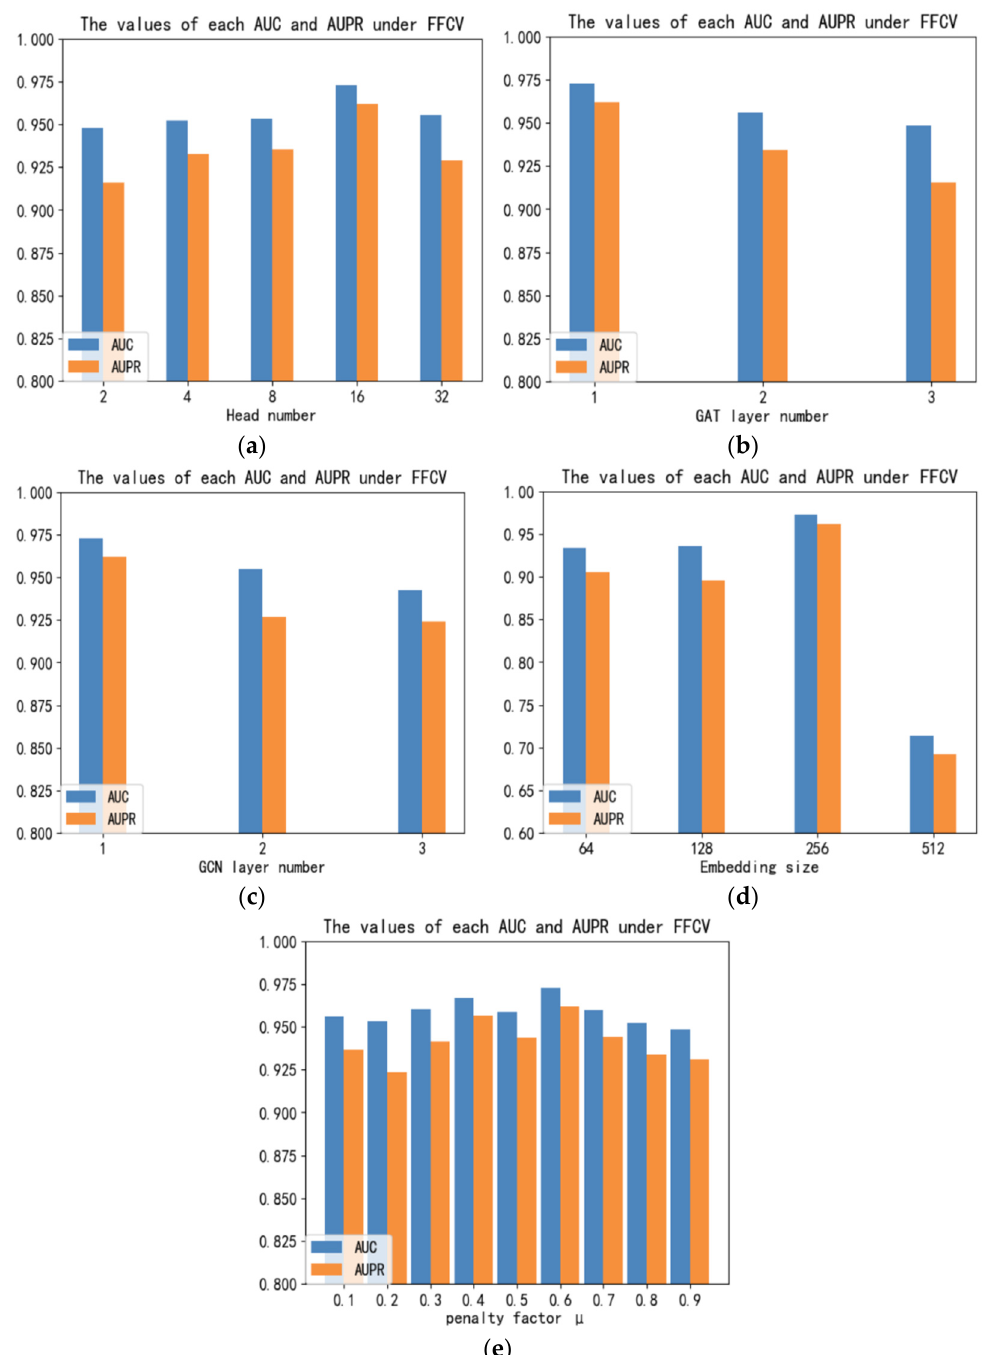
Figure 4. Impact of different parameters on model performance: ( a ) Comparison of AUC and AUPR values for different attention heads. ( b ) Comparison of AUC and AUPR values at different GAT layers. ( c ) Comparison of AUC and AUPR values at different GCN layers. ( d ) Comparison of AUC and AUPR values at different embedding sizes. ( e ) Comparison of AUC and AUPR values on different penalty factors.